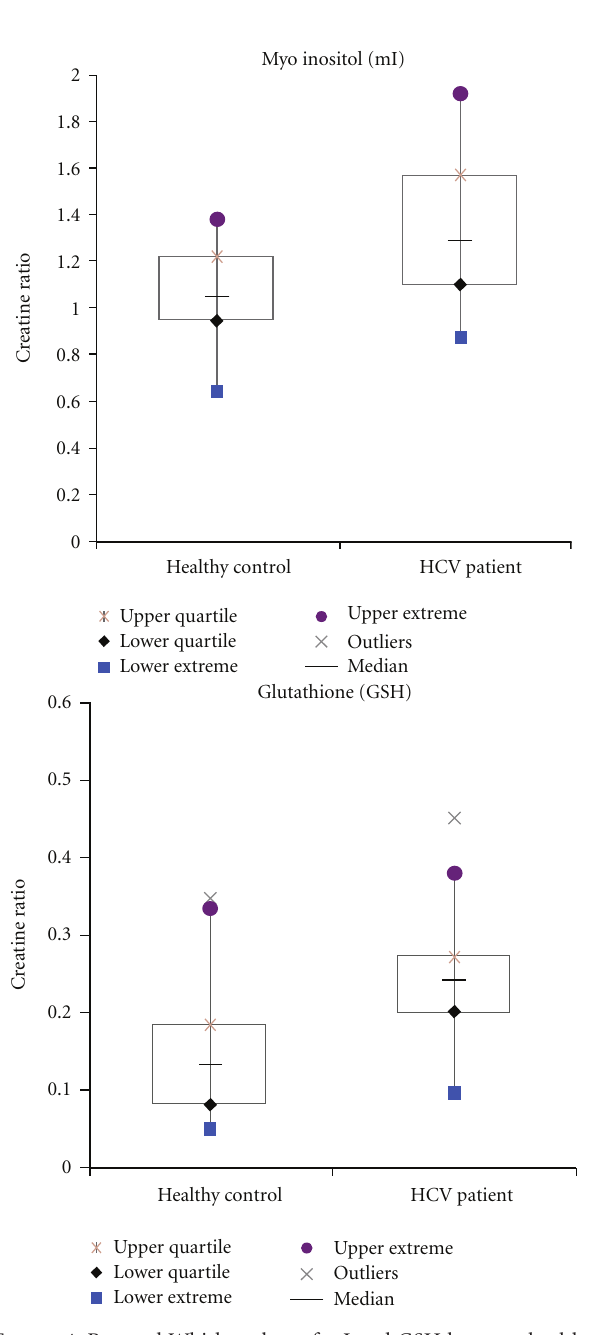
Figure 4: Box and Whisker plots of mI and GSH between healthy controls and HCV+ patients.